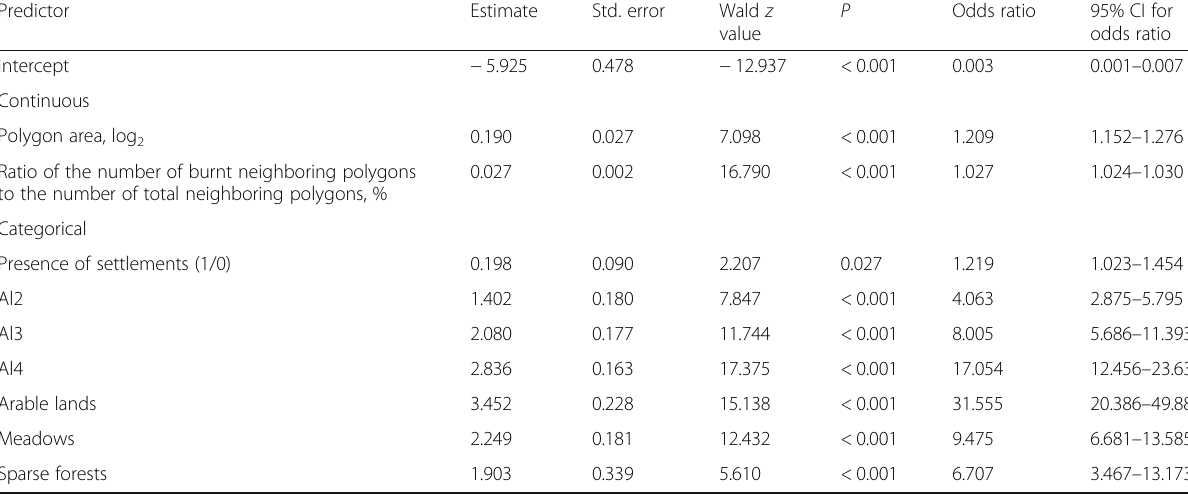
Table 2 Statistically significant results of the logistic regression model of fire occurrences Predictor